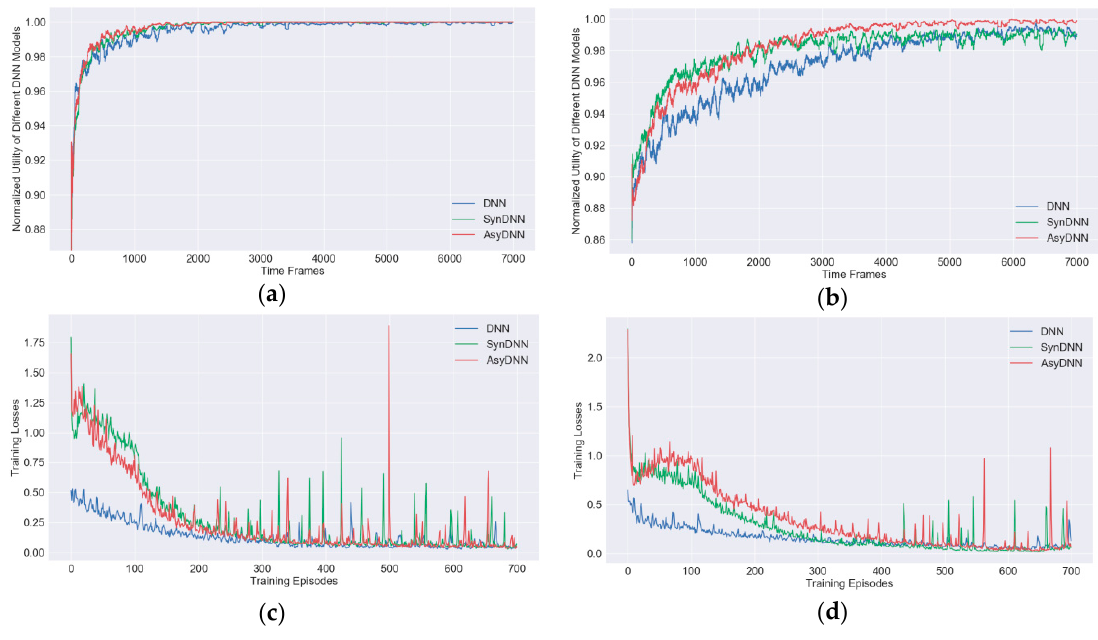
Figure 7. Training processes and training losses of the IRAO algorithm with di ff erent DNN models: ( a ) the training processes under 10 users; ( b ) the training processes under 20 users; ( c ) the training losses under 10 users; ( d ) the training losses under 20